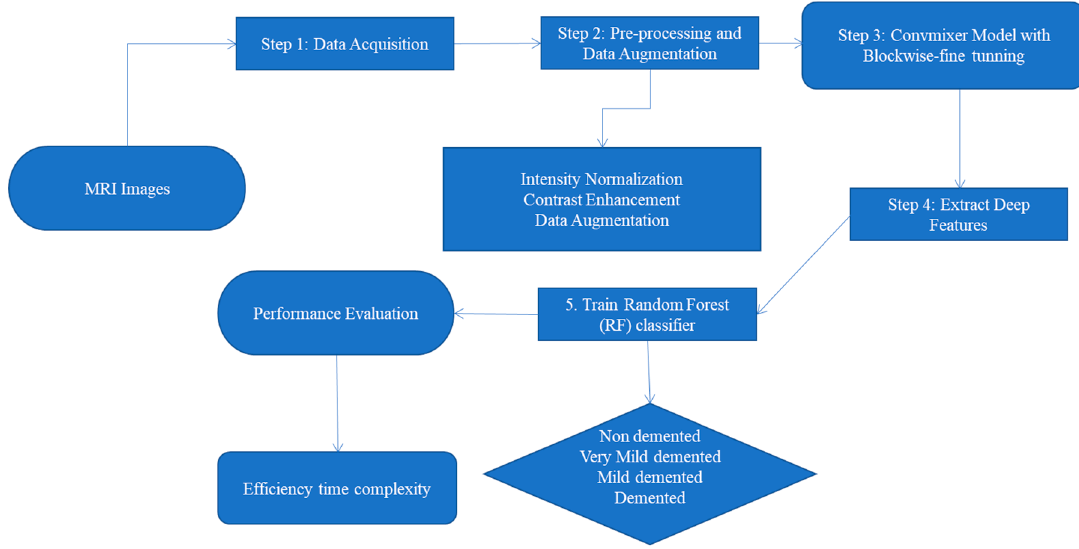
Figure 4. A systematic flow diagram of the proposed CAD-ALZ model to recognize different stages of AD disease during diagnosis through MRI images.